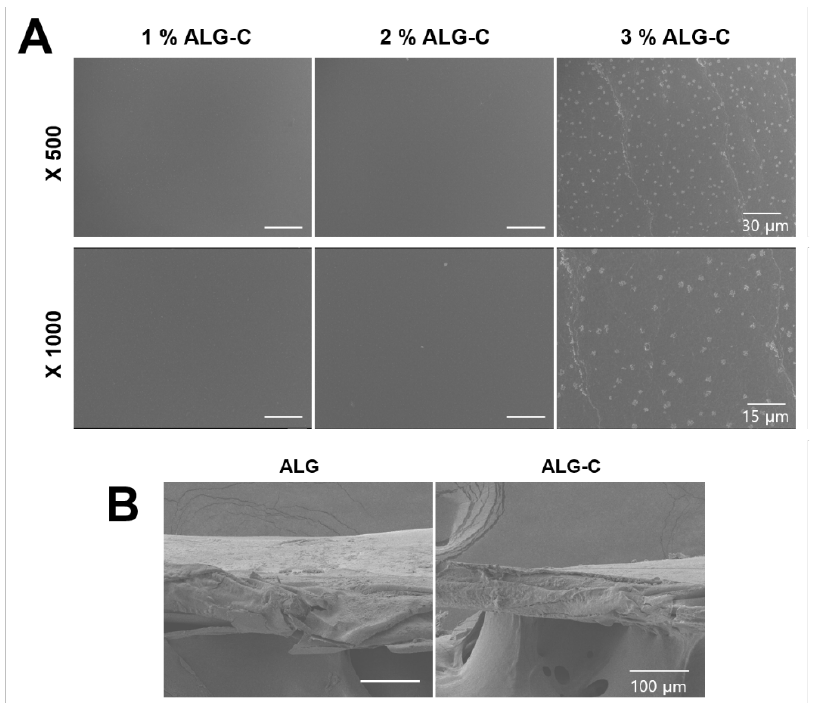
Figure 3. SEM images of films with 3 levels of ALG-C concentrations. ( A ) The ALG-C film with 1% and 2% had a flat and flawless surface, but 3% ALG-C showed a wrinkled surface and lots of aggregates. ( B ) The cross-sectional image of both ALG and ALG-C shows the films had a thickness lower than 100 µm.